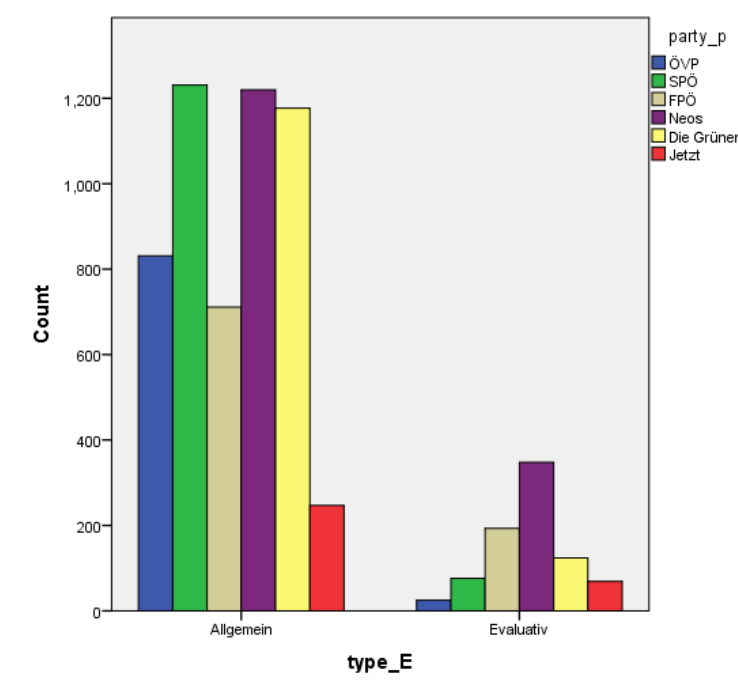
Figure 5. Number of Posts per Party - Splitted into Regular and